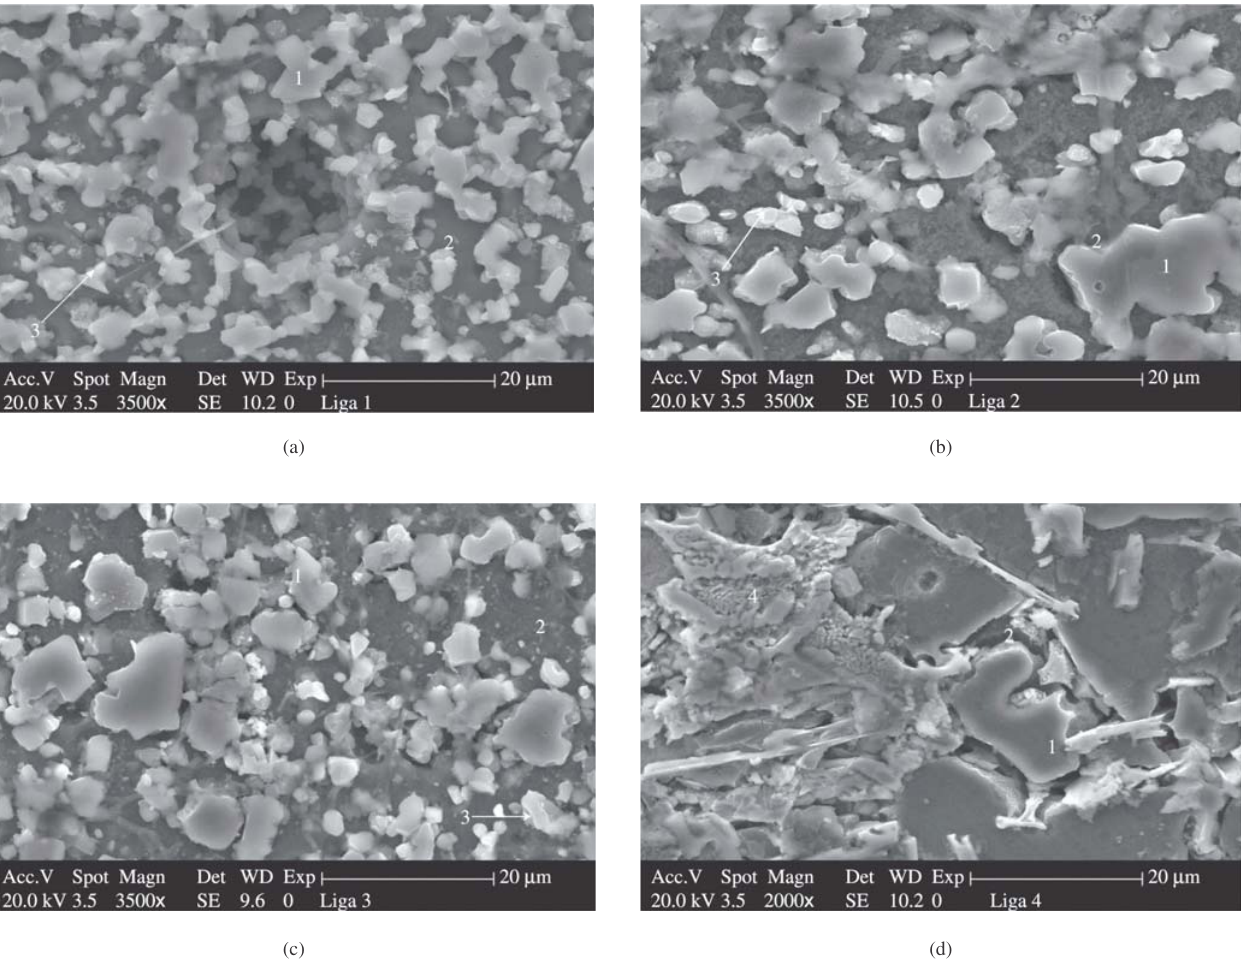
Figure 3. SEM micrographies of Al-Si-Cu hypereutectic alloys, after 6 days of immersion in naturally aerated CSAS: a) alloy 1; b) alloy 2; c) alloy 3; d) alloy 4. Numbers indicate the phases in the alloys and correspond to: (1) primary silicon phase, (2) matrix, (3) copper rich phase, (4)